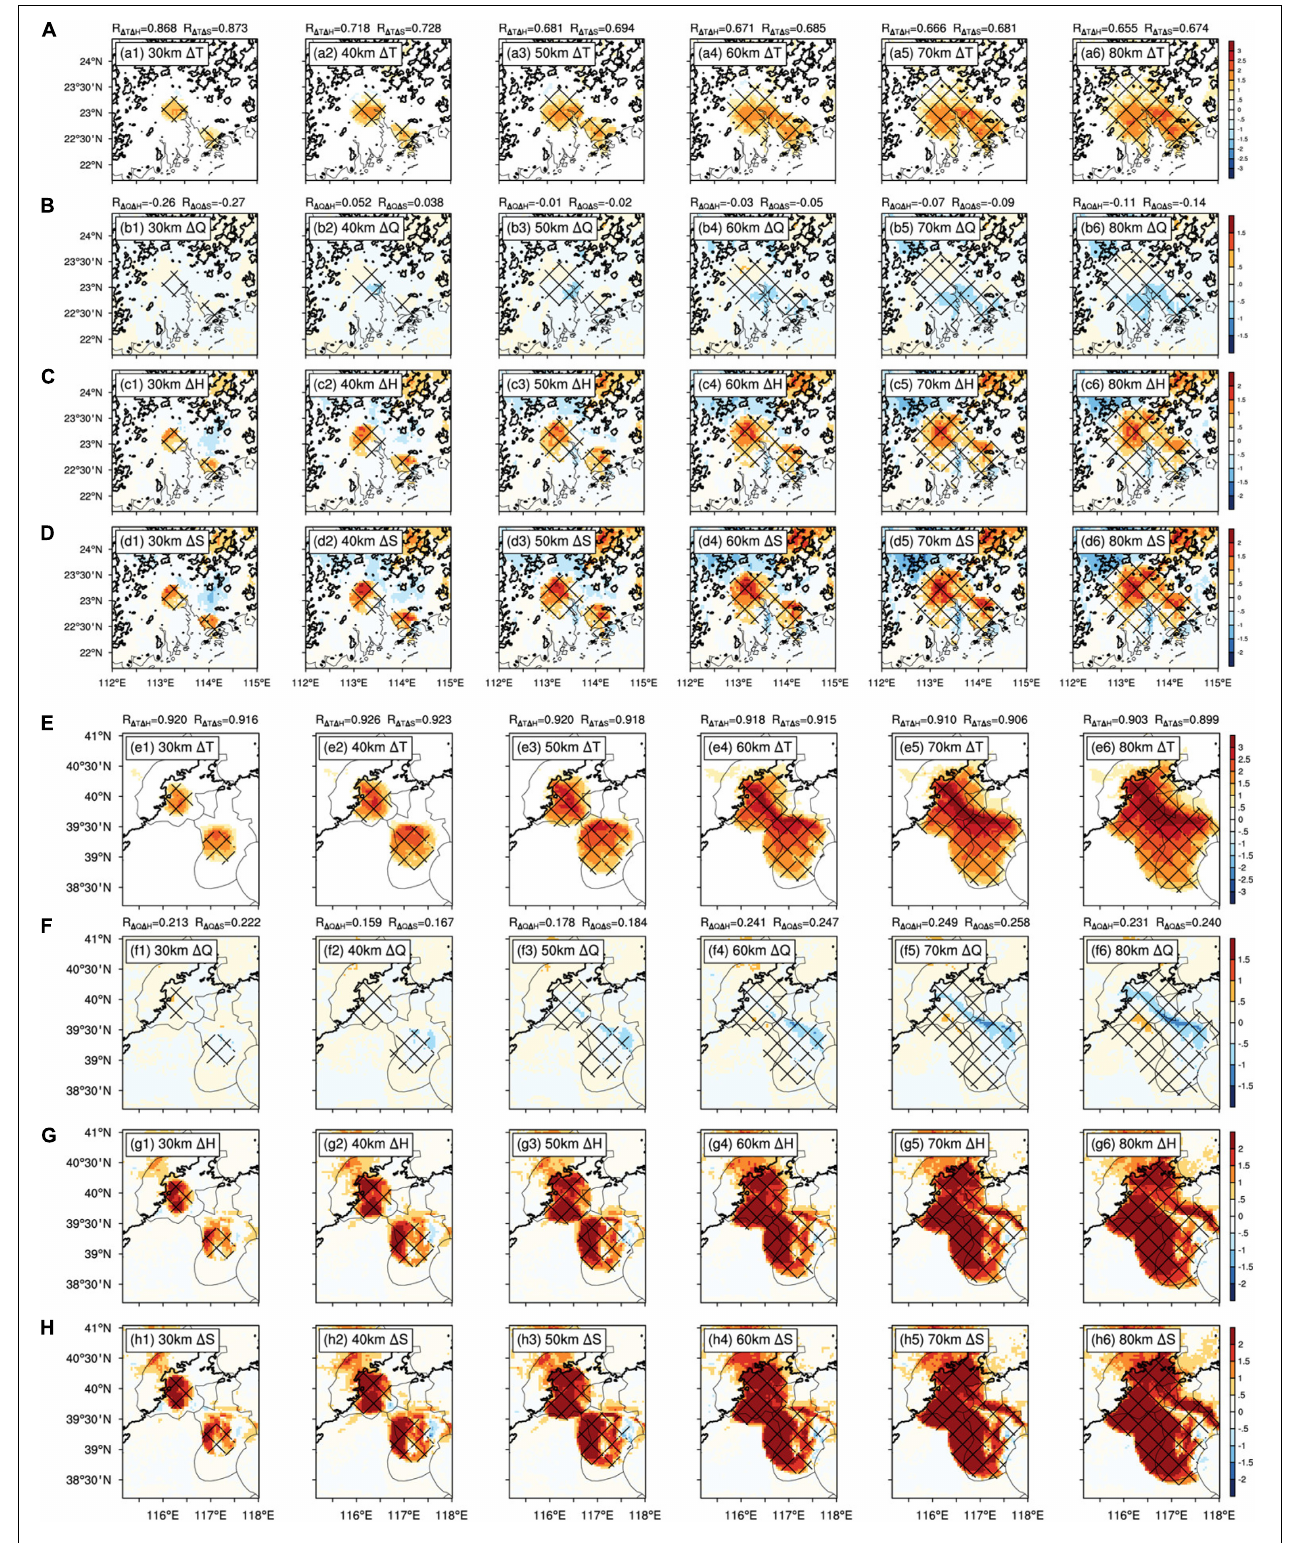
FIGURE 7 | (A-H) The same as Figure 5 but for group 2 experiment in Table 4 by taking account of the impact of increasing city size from R = 30 to 80 km.